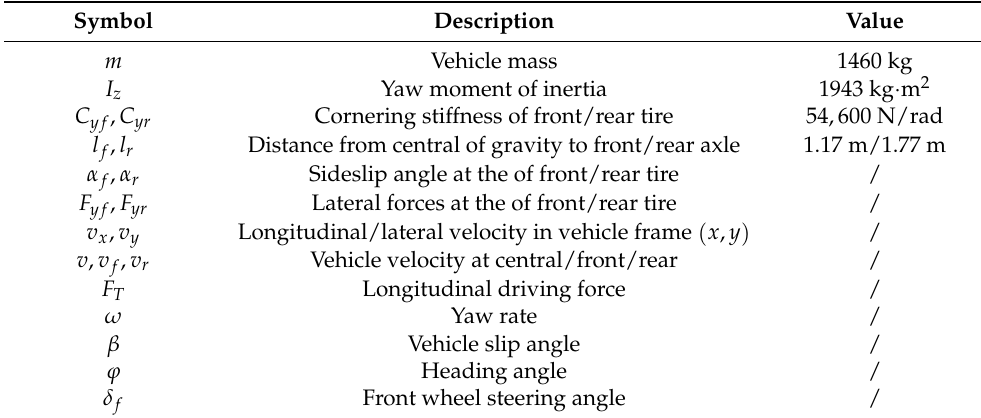
Table 1. Definition of parameters and variables.